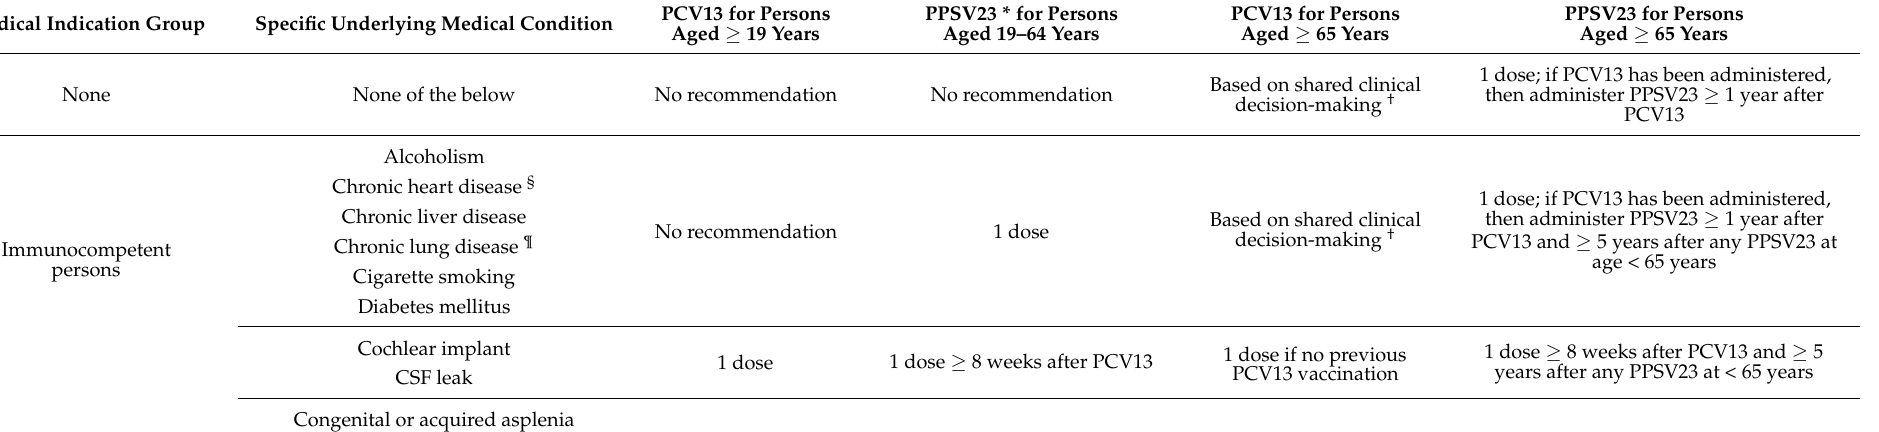
Table 2. Recommendations for the 13-valent pneumococcal conjugate vaccine (PCV13) and 23-valent pneumococcal polysaccharide vaccine (PPSV23) among adults aged ≥ 19 years. Medical Indication